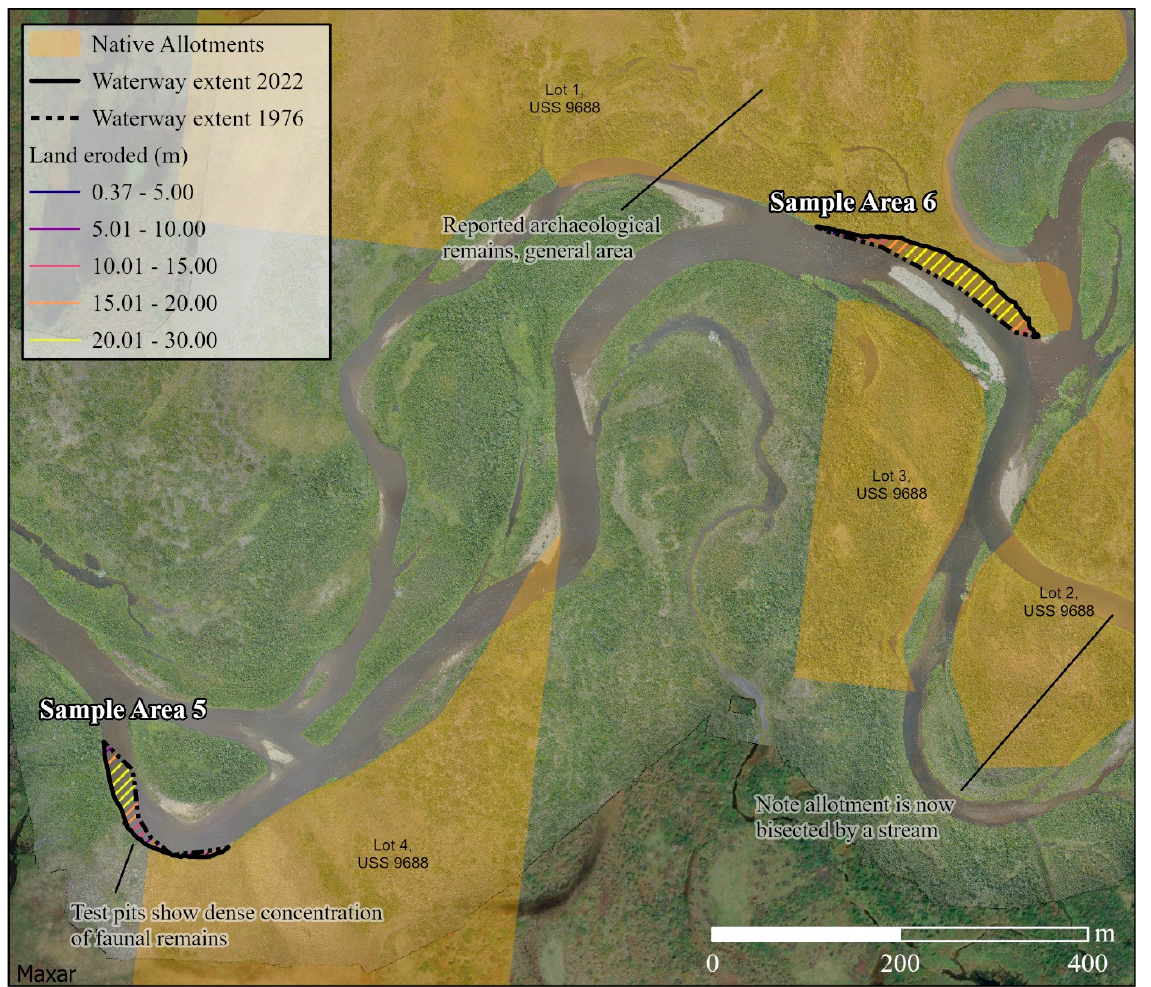
Figure 6. Erosion at the confluence of Bessie Creek and the Agalig. Aerial orthomosaic by authors (2022), basemap by ESRI.